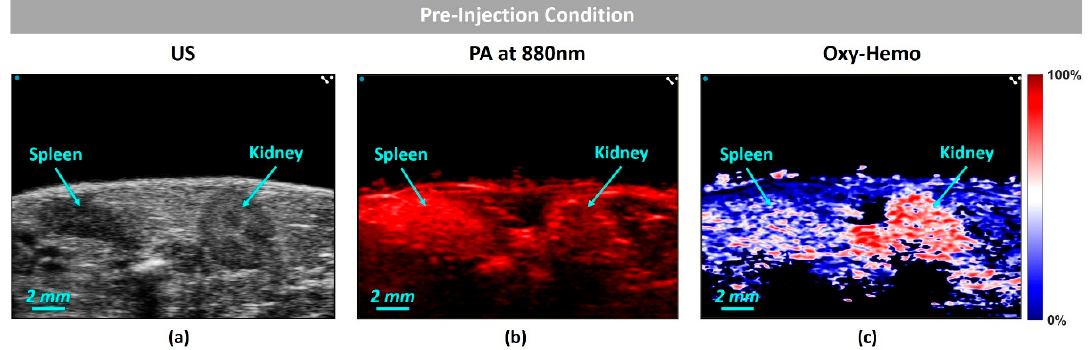
Figure 6. Pre-injection conditions: ( a ) ultrasound (US) image of the kidney–spleen view; respectively ( b ) photoacoustic (PA) image obtained at 880nm, and ( c ) SO 2 map.